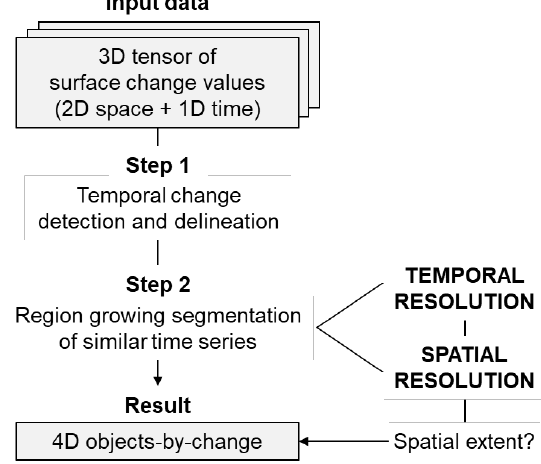
Figure 1 . Experimental design to investigate the influence of reduced spatial and temporal resolutions regarding the spatial object extent resulting from region growing, compared to the results obtained at original resolution of the input data. The analysis is part of the workflow of spatiotemporal segmentation using a 3D tensor of surface change values to extract 4D objects-by-change, i.e. change forms in local areas with similar surface change